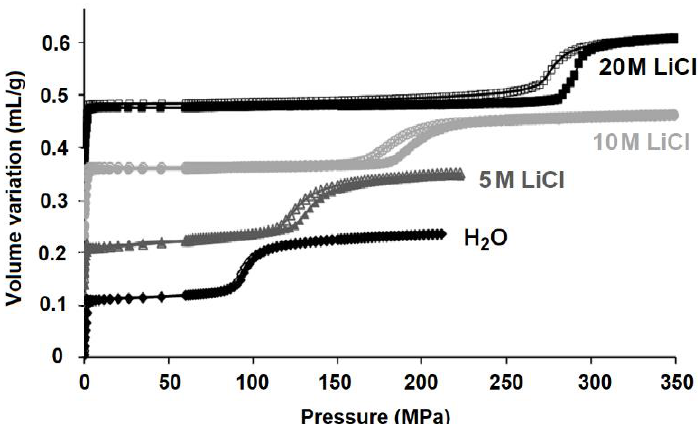
Figure 2. Intrusion pressure values of di ff erent “zeosil–LiCl aqueous solution” systems in function of solution concentration of 0 (water), 5, 10, and 20 M.